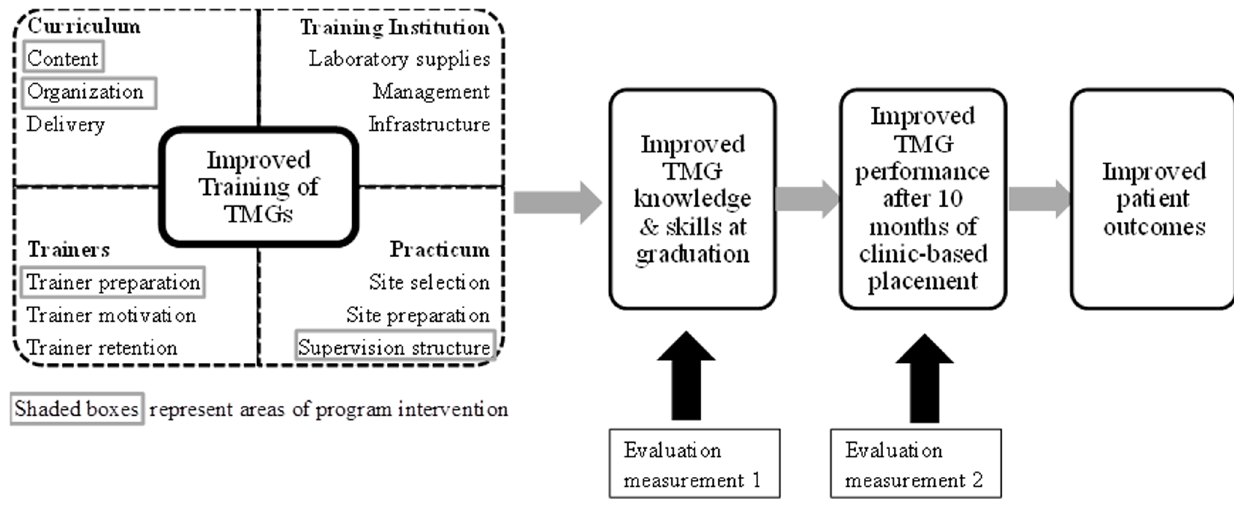
group guide for the final round of data collection for the revised curriculum group. Key informant and focus group questions are